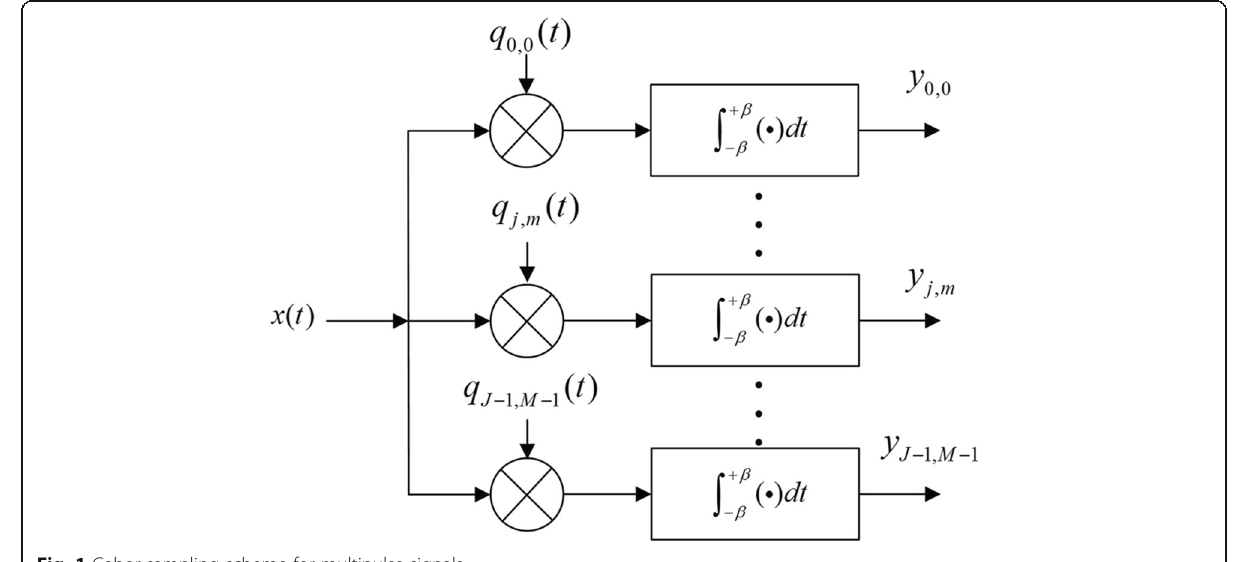
Fig. 1 Gabor sampling scheme for multipulse